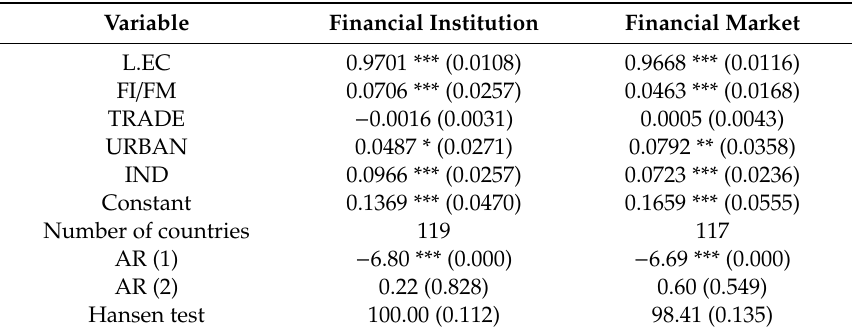
Table 7. Results of the full sample regressions with FI and